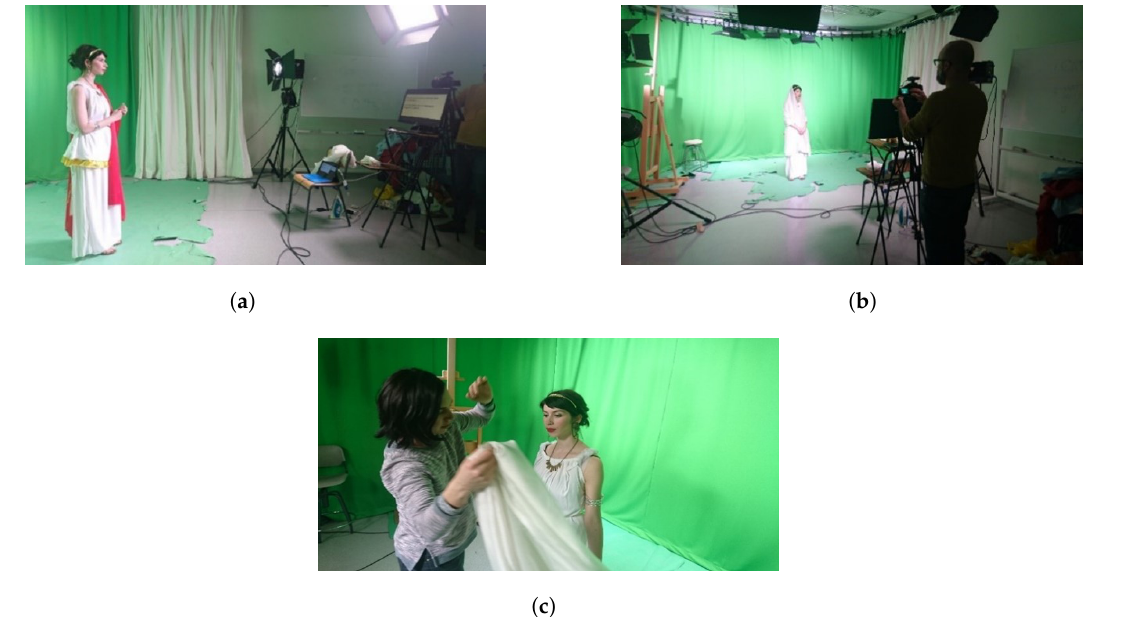
Figure 7. Recording studio: ( a – c ) images show different moments of the recording process. Post-production was carried out with Adobe After Effects CC 2017, where the figure was isolated from the environment to be inserted into the program (see Figure 8). The presentation sequence was especially complex, since it had to be divided into six moments in which Clelia instructs the visitor, where three of these are character loops enabled the ability to await the visitor’s reaction. In the image below, you can see the sections defined as loops marked in pink and those of a single reproduction in green.